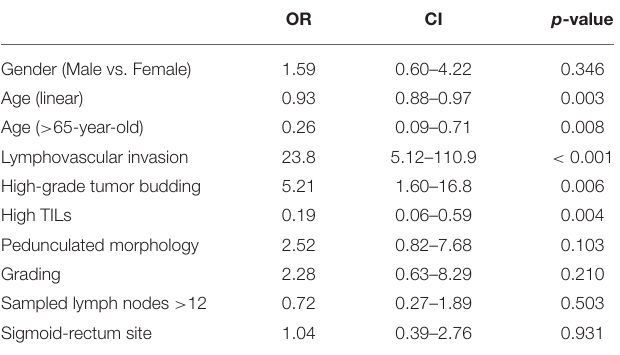
TABLE 3 | Univariate logistic regression analysis between clinico-pathological variables and lymph nodes metastasis. OR CI p -value Gender (Male vs. Female)